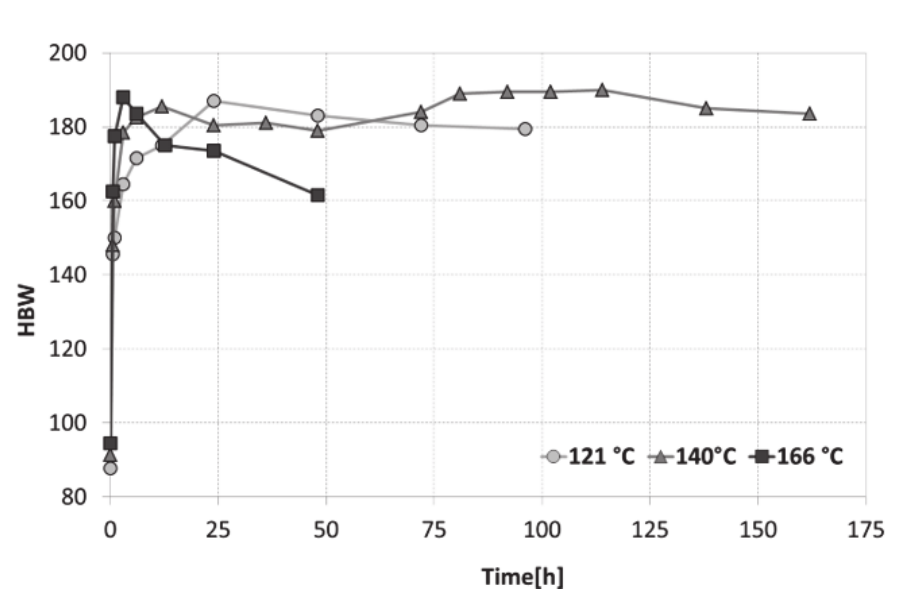
Figure 3: Hardness curves at different ageing temperatures, varying the soaking